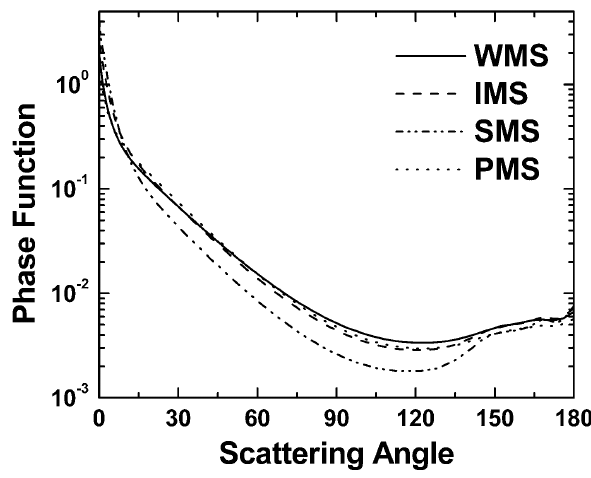
Figure 3. Phase function of the modeled composite aerosol system for different seasons. Note the effect of increased coarse aerosols on the phase function in the summer monsoon season. The components of the diurnally averaged, direct, short wave radiative forcing for clear sky conditions are shown in Fig. 4 for different seasons, with the panels from bottom to top representing TOA, surface and atmospheric forcing re- spectively. The shaded portion in Fig. 4 represents the val- ues correspond to the upper limits of the radiative